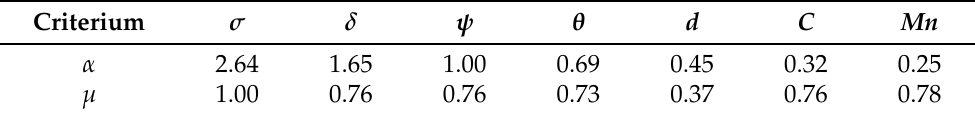
Table 2. The values of the local criteria µ and their relative importance (weights) α in the optimum point. Criterium σ